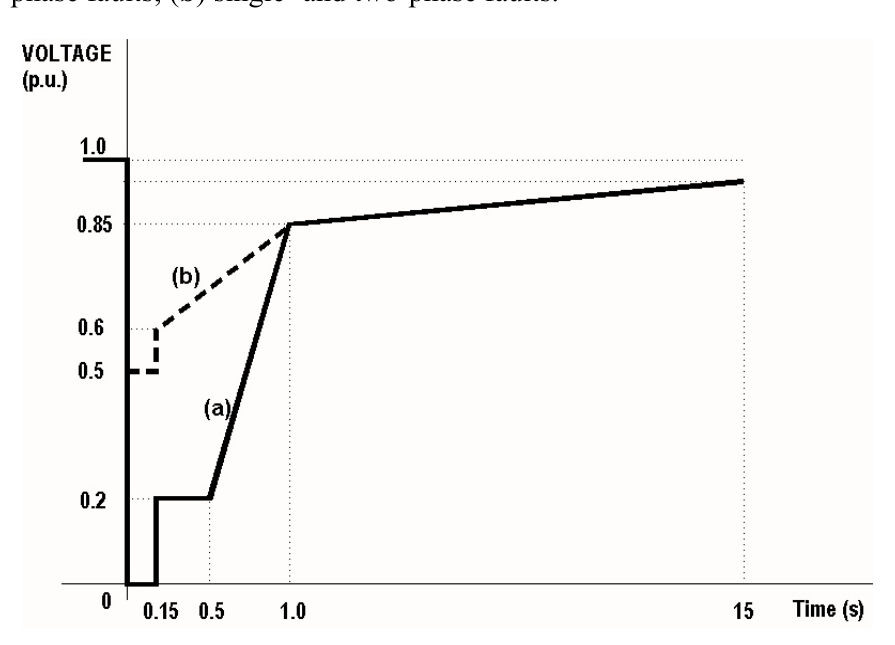
Figure 1. Low voltage ride through (LVRT) as specified in Spanish grid code: ( a ) three-phase faults; ( b ) single- and two-phase